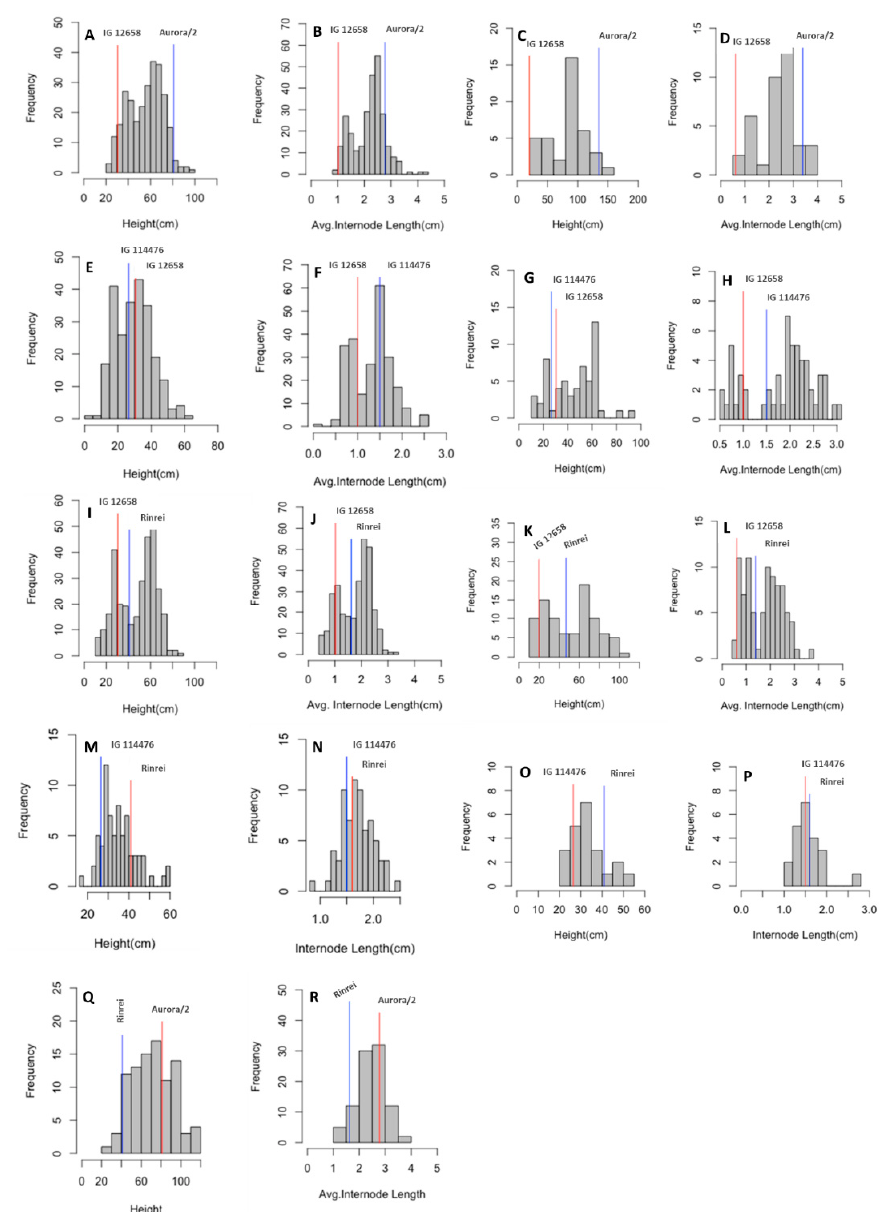
Figure 1. Frequency distributions of the height and average internode of the main stem for studied F 2 populations. ( A ) Aurora/2 × IG 12658 height, field (n = 273, P (W) = 0.001); ( B ) Aurora/2 × IG 12658 average internode, field (n = 273, P (W) = 0.007); ( C ) Aurora/2 × IG 12658 height, growth chamber (n = 38, P (W) = 0.002); ( D ) Aurora/2 × IG 12658 average internode, growth chamber (n = 38, P (W) = 0.059); ( E ) IG 114476 × IG 12658 height, field (n = 239, P (W) = 0.001); ( F ) IG 114476 × IG 12658 average internode, field (n = 239, P (W) = 0.002); ( G ) IG 114476 × IG 12658 height, growth chamber (n = 61, P (W) = 0.032); ( H ) IG 114476 × IG 12658 average internode, growth chamber (n = 61, P (W) = 0.001); ( I ) Rinrei × IG 12658 height, field (n = 314, P (W) = 0.001); ( J ) Rinrei × IG 12658 average internode, field (n = 314, P (W) = 0.001); ( K ) Rinrei × IG 12658 height, growth chamber (n = 88, P (W) = 0.001); ( L ) Rinrei × IG 12658 average internode, growth chamber (n = 88, P (W) = 0.451); ( M ) IG 114476 × Rinrei height, field (n = 144, P (W) = 0.001); ( N ) IG 114476 × Rinrei average internode, field (n = 144, P (W) = 0.001); ( O ) Rinrei × IG 114476 height, field (n = 44, P (W) = 0.308); ( P ) Rinrei × IG 114476 average internode, growth chamber (n = 44, P (W) = 0.580); ( Q ) Rinrei × Aurora/2 height, field (n = 93, P (W) = 0.349); ( R ) Rinrei × Aurora/2 average internode, field (n = 93, P (W) = 0.139). P (W), P value of the Shapiro–Wilk test for normality.